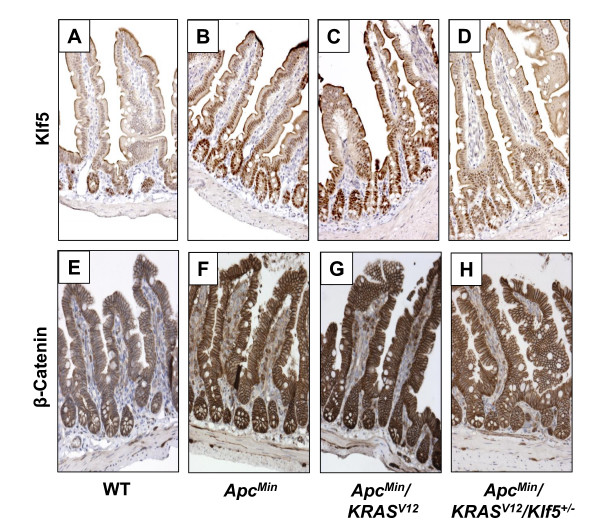
Immunohistochemical analyses of Klf5 and β-catenin in the normal-appearing small intestines of wild type and mutant mice. The panels are representative sections of normal-appearing small intestinal tissues stained with Klf5 (A-D) or β-catenin antibodies (E-H). Formalin-fixed, paraffin-embedded tissue sections (5 μm in size) were deparaffinized and antigen-retrieved using Citrate buffer (pH 6.0). Sections were stained with appropriate primary and secondary antibodies and developed using DAB chromogen. The resulting brown color is representative of protein expression. The sections were also counter stained with hematoxylin, which stains the nuclei blue. Panels A & E represent Klf5 and β-catenin staining, respectively, in wild type (WT) normal intestinal tissues. Panels B & F show staining in ApcMin tissues, while panels C & G and panels D & H show representative staining in ApcMin/KRASV12 and ApcMin/KRASV12/Klf5+/- tissues, respectively.